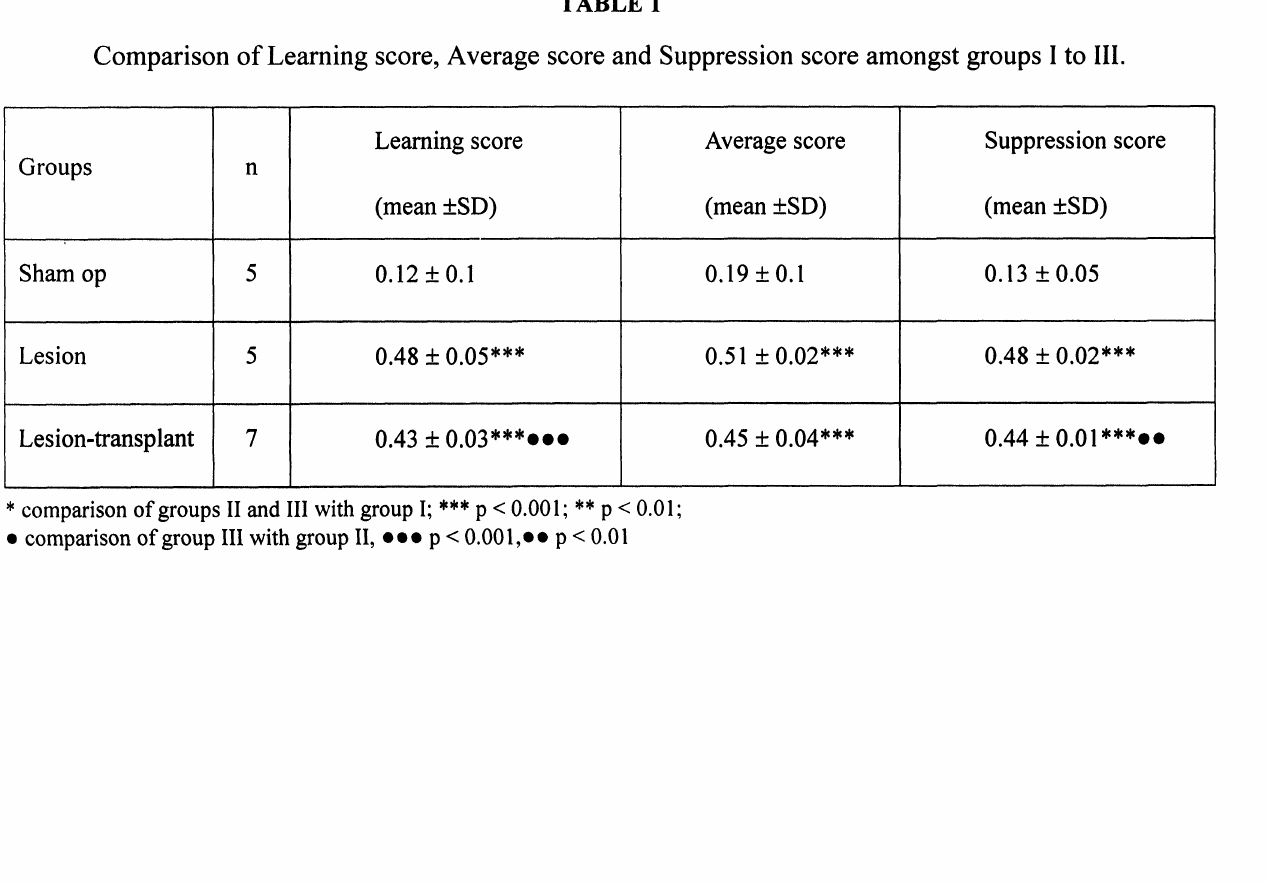
Fig. 1" Photomicrograph of the hematoxylin-eosin and cresyl violet stained stained brain sections of a rat showing electrolytic lesion (A) transplant tissue (B)at the level of central nucleus of amygdala, respectively. Opt is optic tract, L is the site of lesion and T is the transplanted tissue.